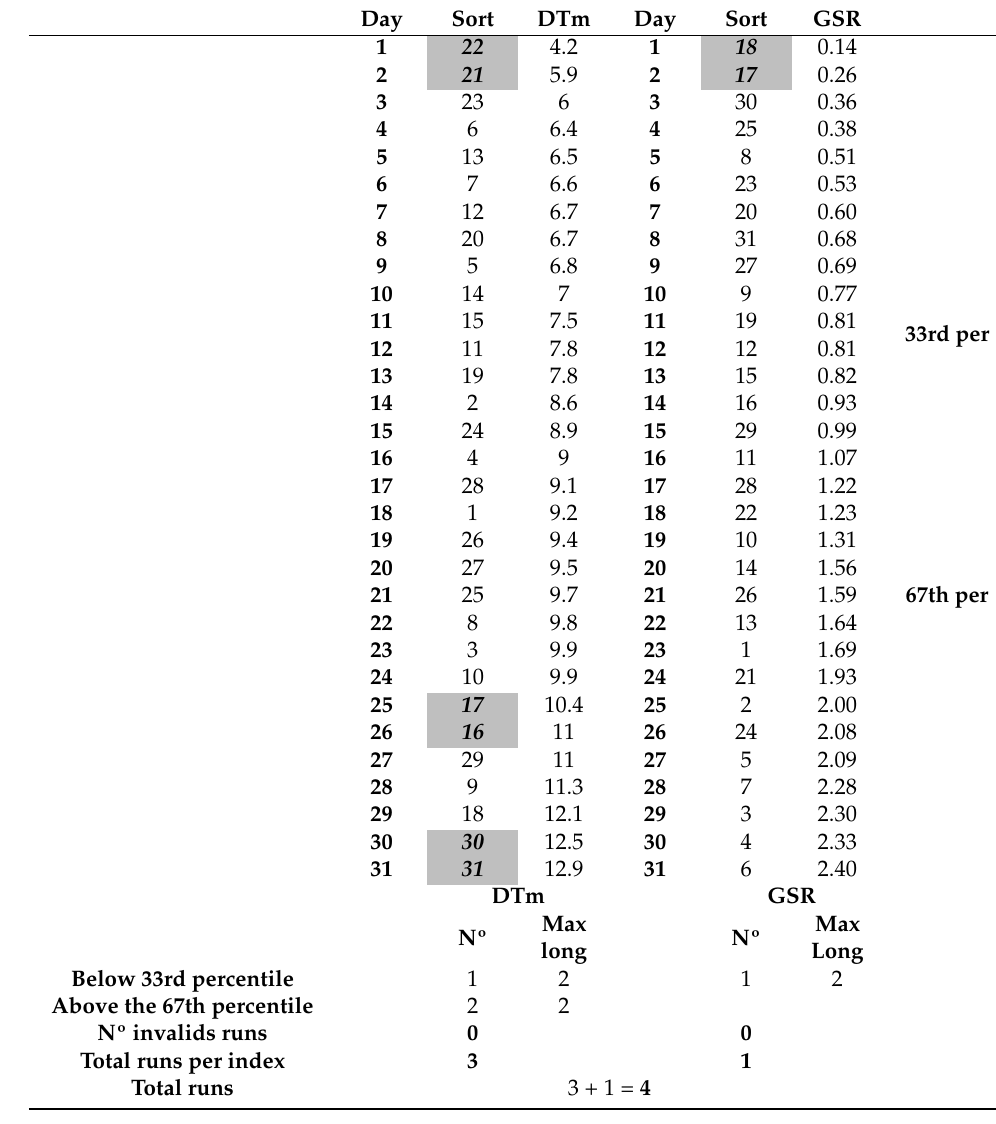
Table 7. Consistency analysis for the month of January 2013, with sorted